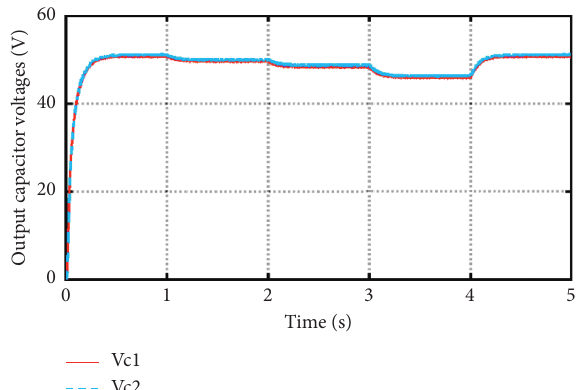
Figure 14: Output capacitor voltages of